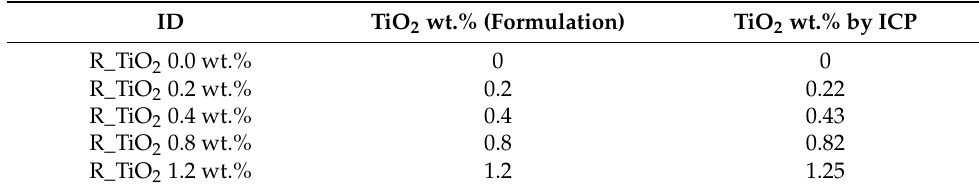
Table 1. TiO 2 NP contents in the 3D-printed